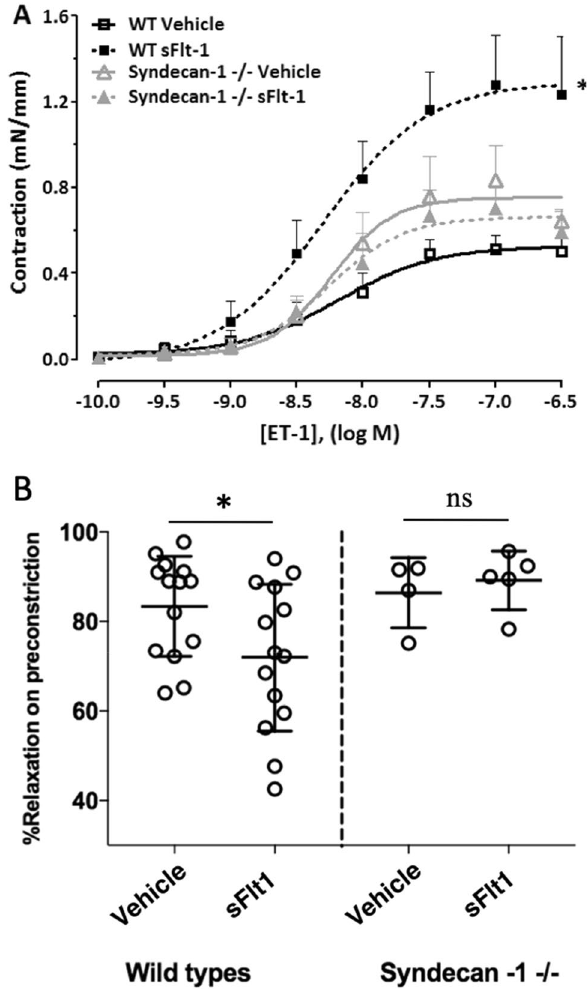
Figure 5. Endothelin-1-induced contraction in sFlt1 and vehicle-treated on syndecan-1 deficient mice and wild type controls. Syndecan-1 deficient mice and wild type controls were treated with sFlt1 or vehicle during two weeks. Carotid arteries were isolated for comparison of contractile responses, vasoconstriction is expressed in milliNewton per millimeter (mN/mm). ( A ) In wild types (WT), sFlt1 infusion augments maximal endothelin- 1-induced vasoconstriction compared to vehicle (N = 6 vs. 6, p = 0.03). In sydencan-1 -/- mice, endothelin-1- induces vasoconstriction similar after sFlt1 and vehicle treatment (N = 5–4, p = 0.68). ( B ) In wild types, maximal methacholine-induced vasodilatation (after preconstriction with phenylephrine) is decreased in sFlt1-treated compared to vehicle-treated mice (N = 14 vs 14, p = 0.04). In sydecan-1 -/- mice, maximal methacholine-induced vasodilatation is similar after sFlt1 and vehicle treatment (N = 5–4). Bars represent mean ± SEM, ns indicates